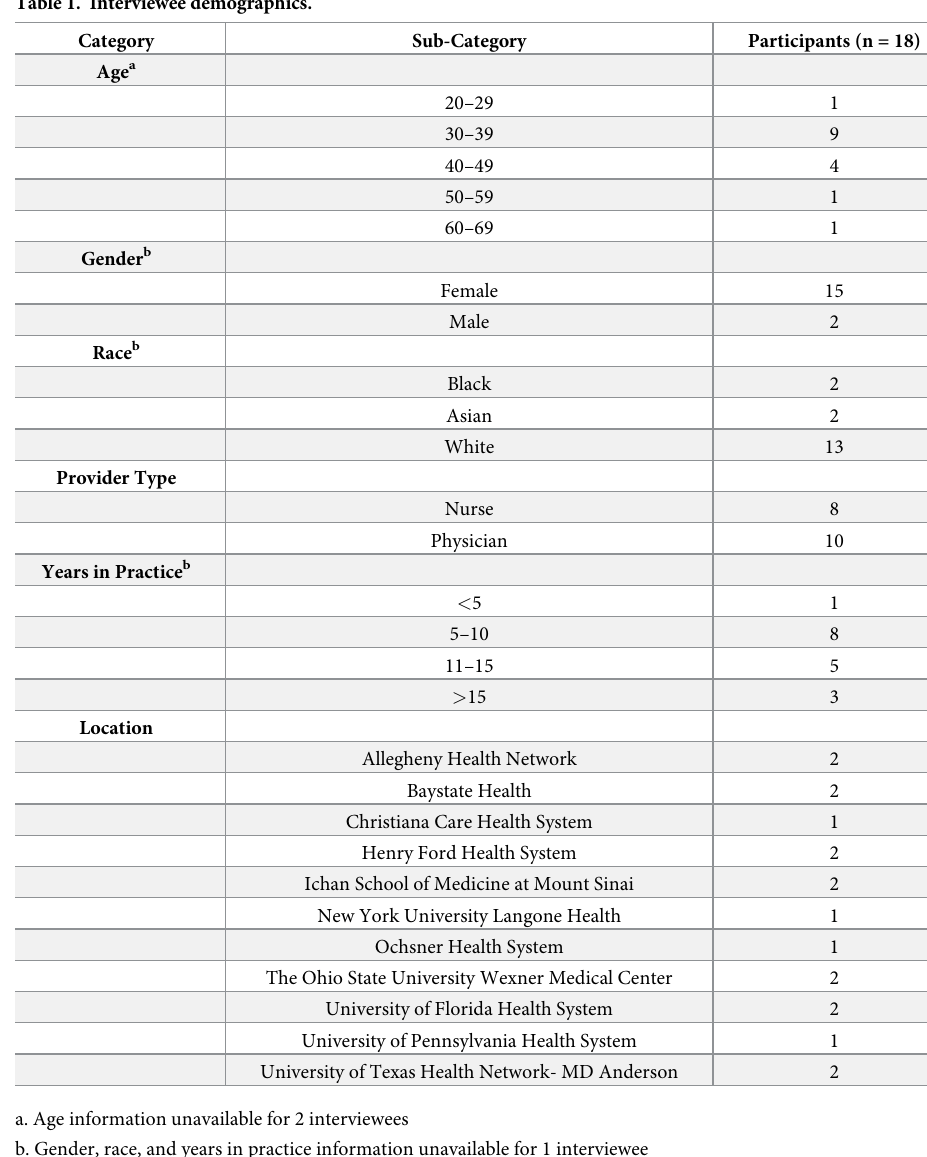
Table 1. Interviewee